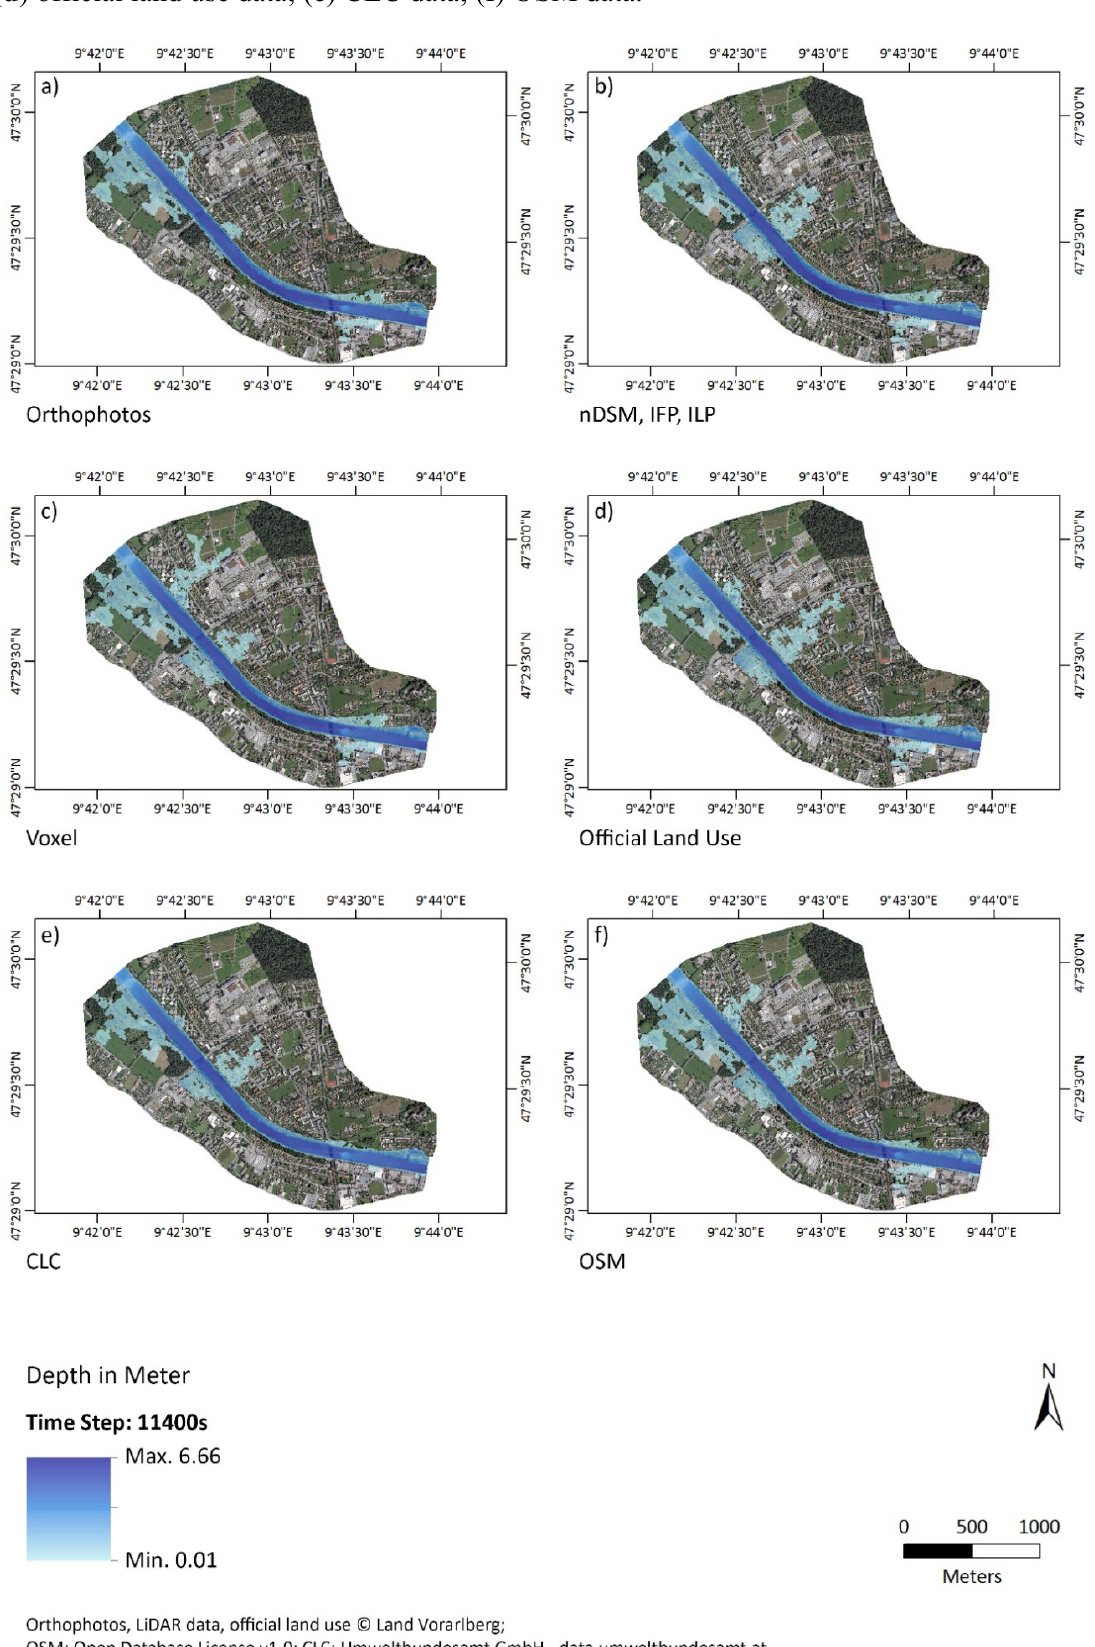
Figure 5. Results of the flood simulation at time step 11,400 s with water depth in meter based on the roughness derivation with ( a ) orthophotos; ( b ) nDSM, IFP, ILP; ( c ) voxel; ( d ) official land use data; ( e ) CLC data; ( f ) OSM